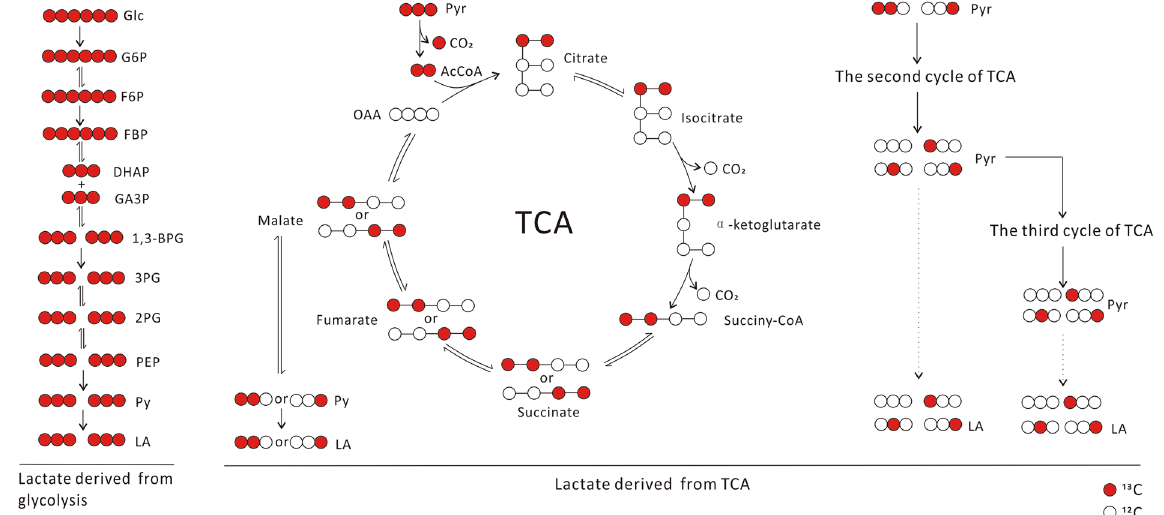
Figure 2. The metabolic pathways that generate various lactate isotopomers and isotopologues in 4T1 cells, traced by [U- 13 C] glucose. Besides [U- 13 C]lactate, there are trace amount of other lactate isotopologues, which could be generated from [U- 13 C]pyruvate through tricarboxylic cycle to produce [1,2- 13 C 2 ]malate and [3,4- 13 C 2 ]malate, which, via catalysis of malic enzyme, generate [1,2- convert to corresponding lactate. [1,2- 13 C 2 ]pyruvate and [3- 13 C]pyruvate can enter Krebs cycle, leading to generation of other lactate isotopomers.